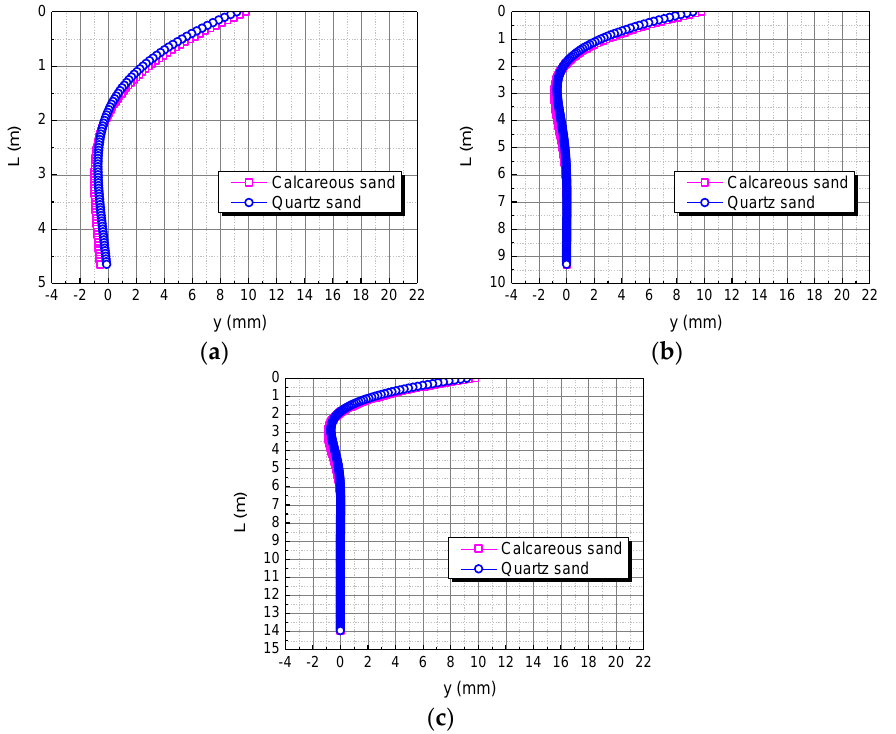
Figure 12. Effect of pile length on horizontal displacement of pile body. ( a ) L; ( b ) 2 L; ( c ) 3 L.